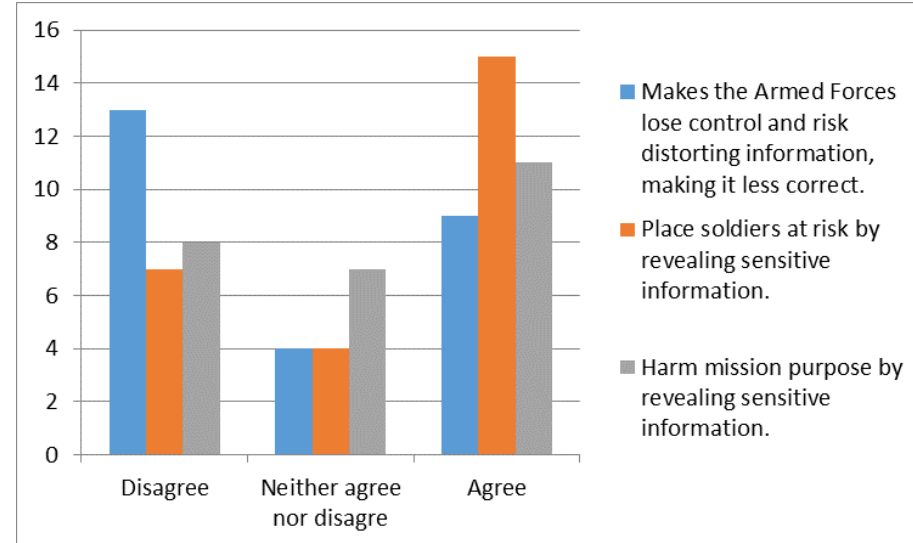
Figure 2. Risks with using social media.